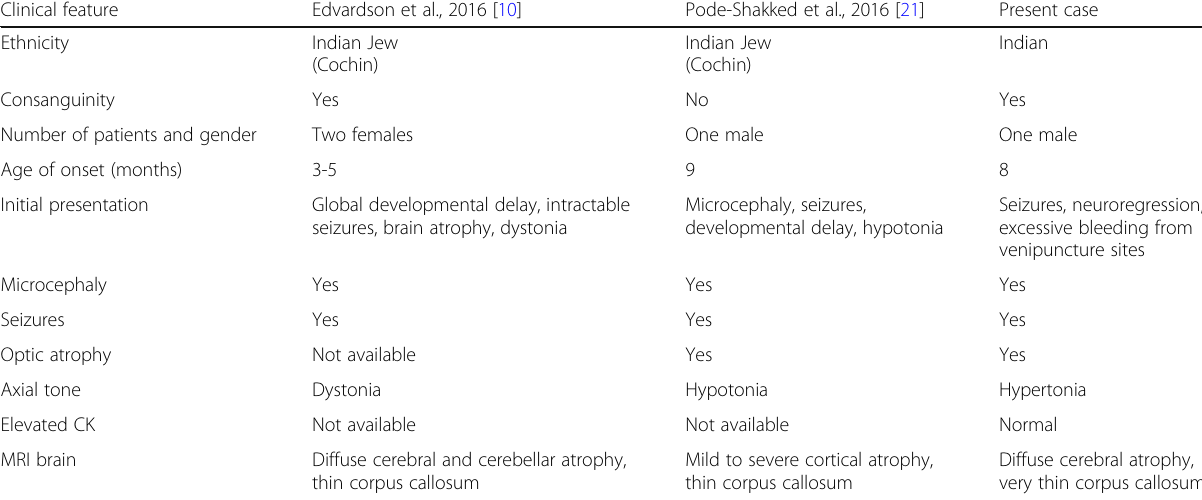
Table 2 Comparison of clinical presentations of p.Ala475Thr patients Clinical